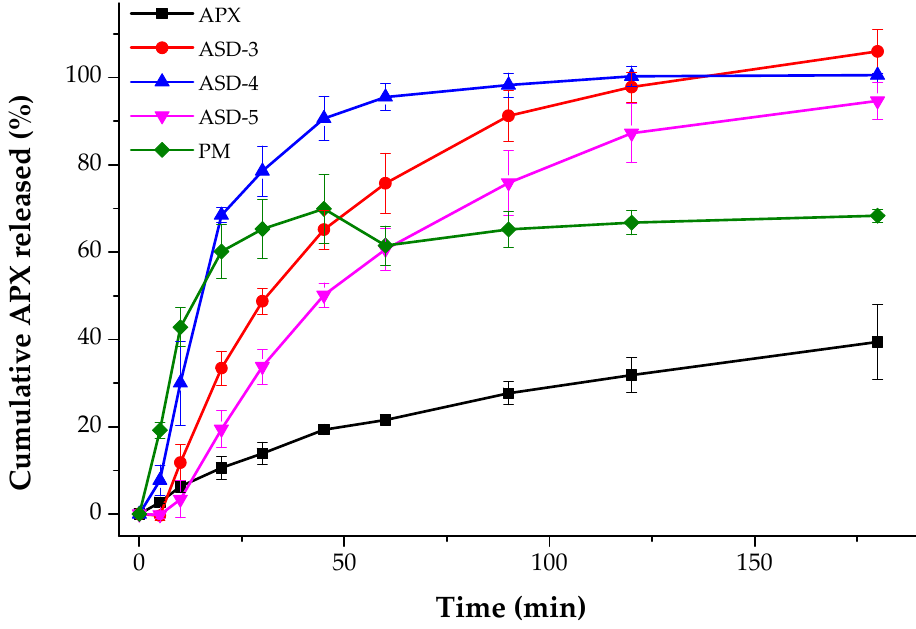
Figure 6. Powder dissolution rate of APX, ASD-3, ASD-4, ASD-5 and PM.